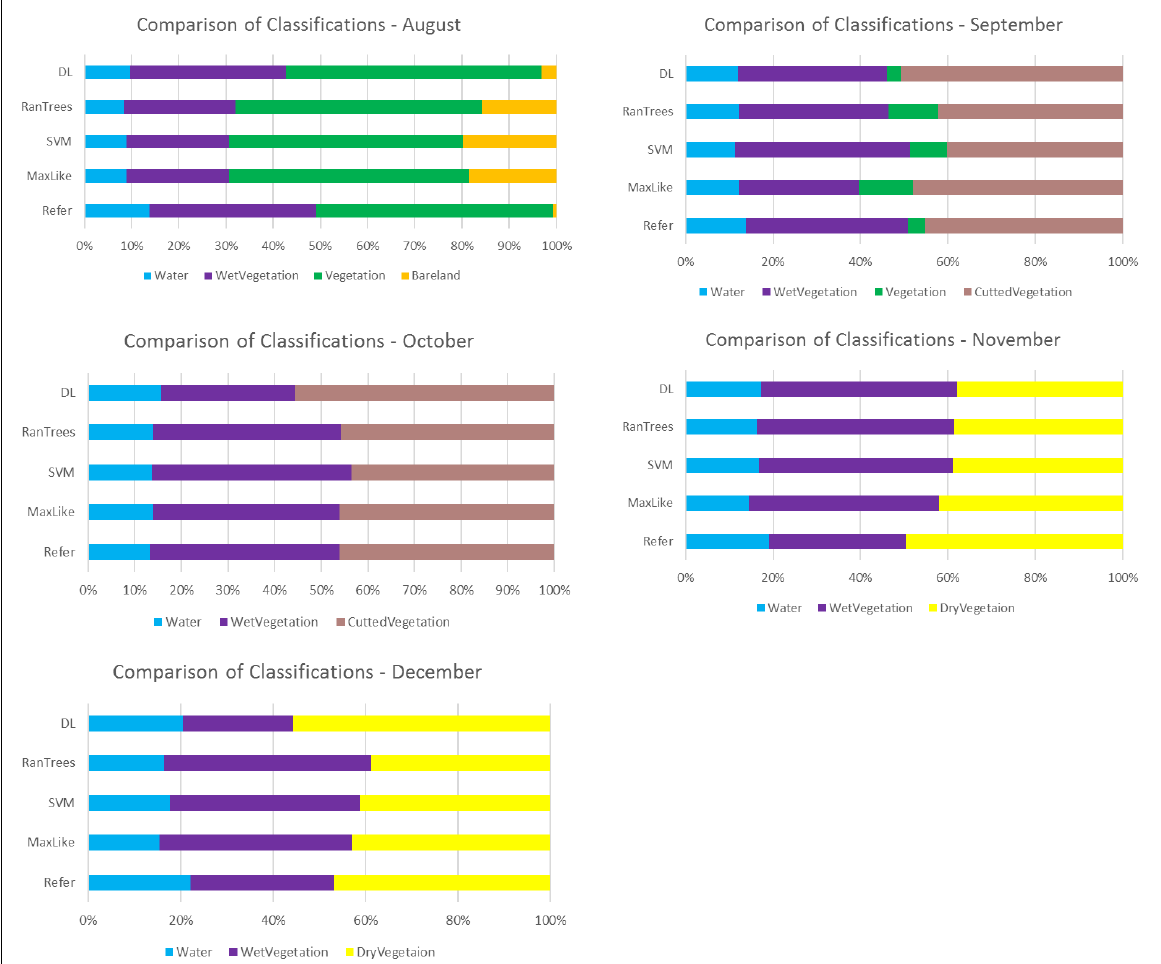
Figure 7. Comparison of classifications